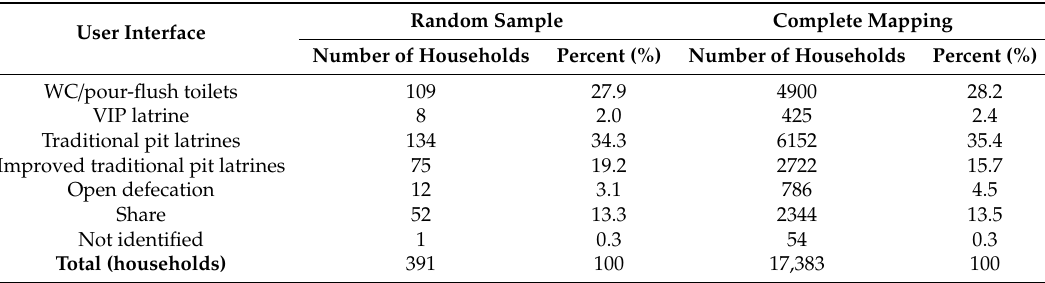
Table 5. Comparison of sanitation user interface.